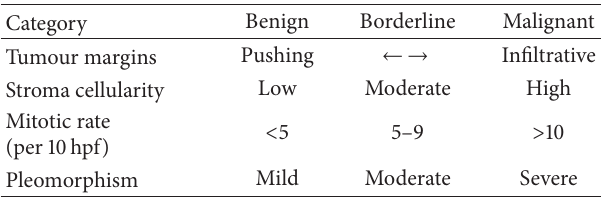
Table 1: Criteria used to classify histological types as proposed by Azzopardi [7] and Salvadori et al.